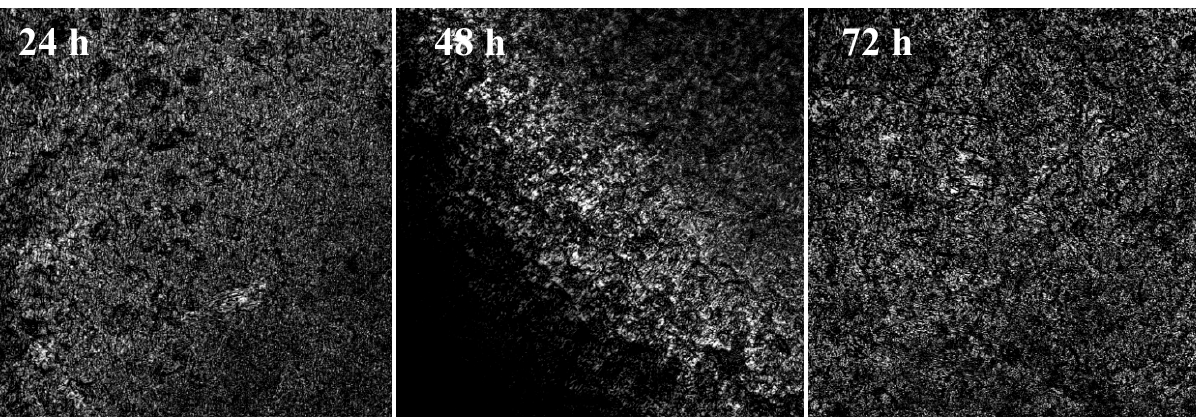
Figure 6. CLSM images of S. aureus biofilm developed on Fe 3 O 4 @C 14 -VAN coated substrata at 24 h, 48 h and 72 h; bacteria occur as punctiform, round cells distributed on the coated